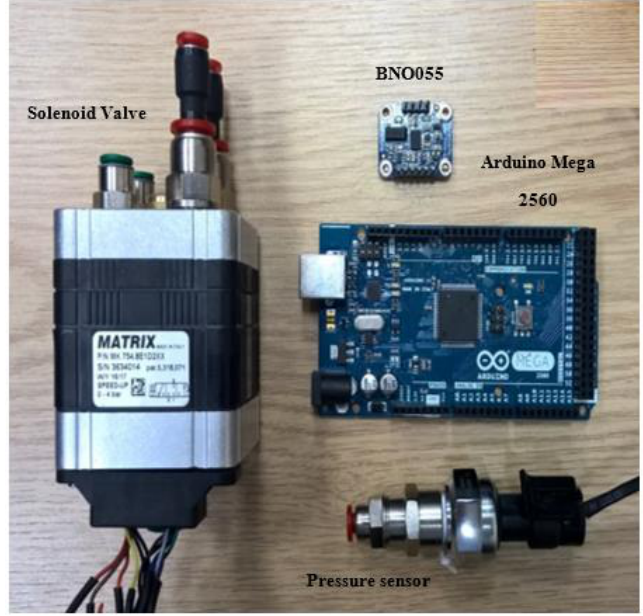
Figure 4. The experiment components. Table 1. The maximum bending angle at different loads for 30 cm SBCA.